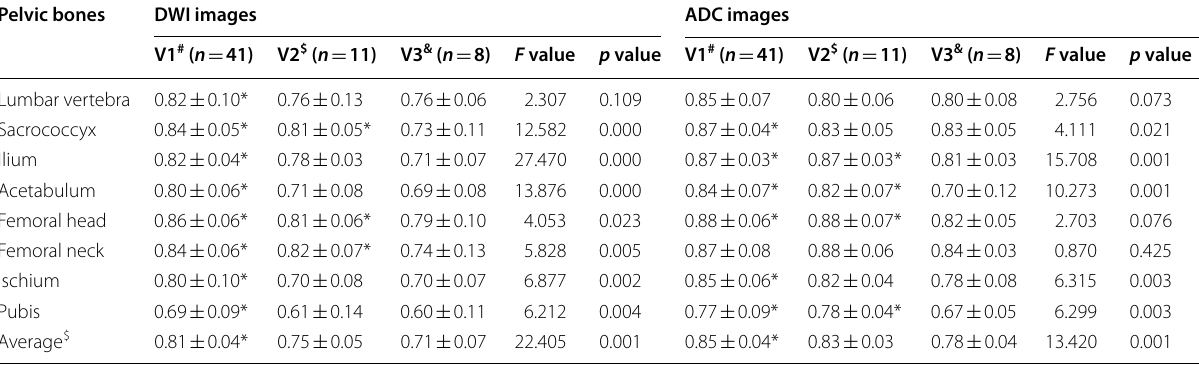
Unless otherwise specified, data are mean DSC value # V1 indicates Vendor 1: 3.0 T Discovery; $ V2 indicates Vendor 2: 1.5 T Intera; & V3 indicates Vendor 3: 1.5 T Avanto * indicates a significantly high DSC value